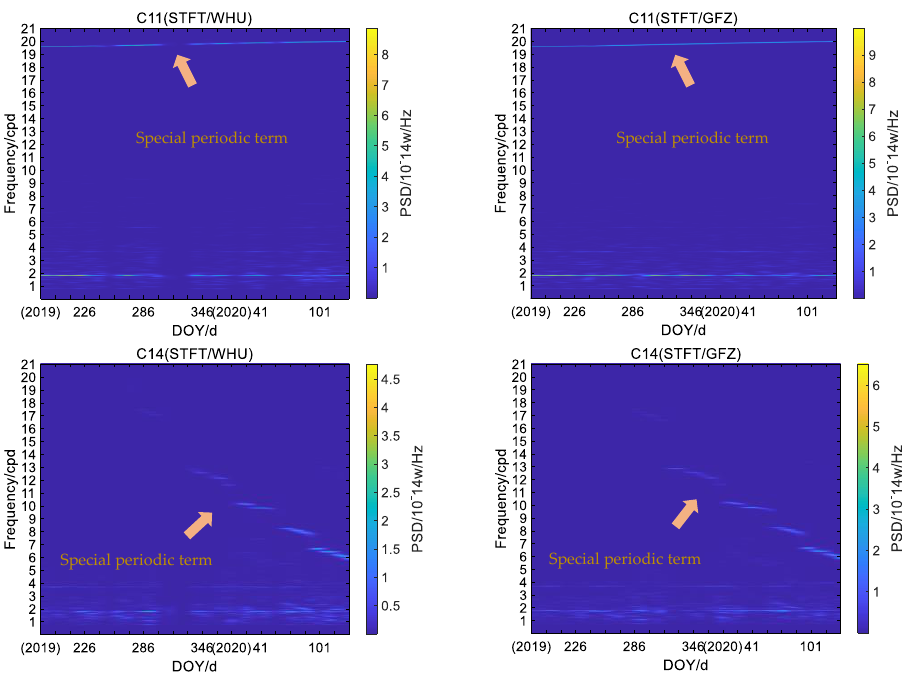
Figure 7. The spectrogram of C11 and C14 for WHU (left) and GFZ (right) clock offsets.